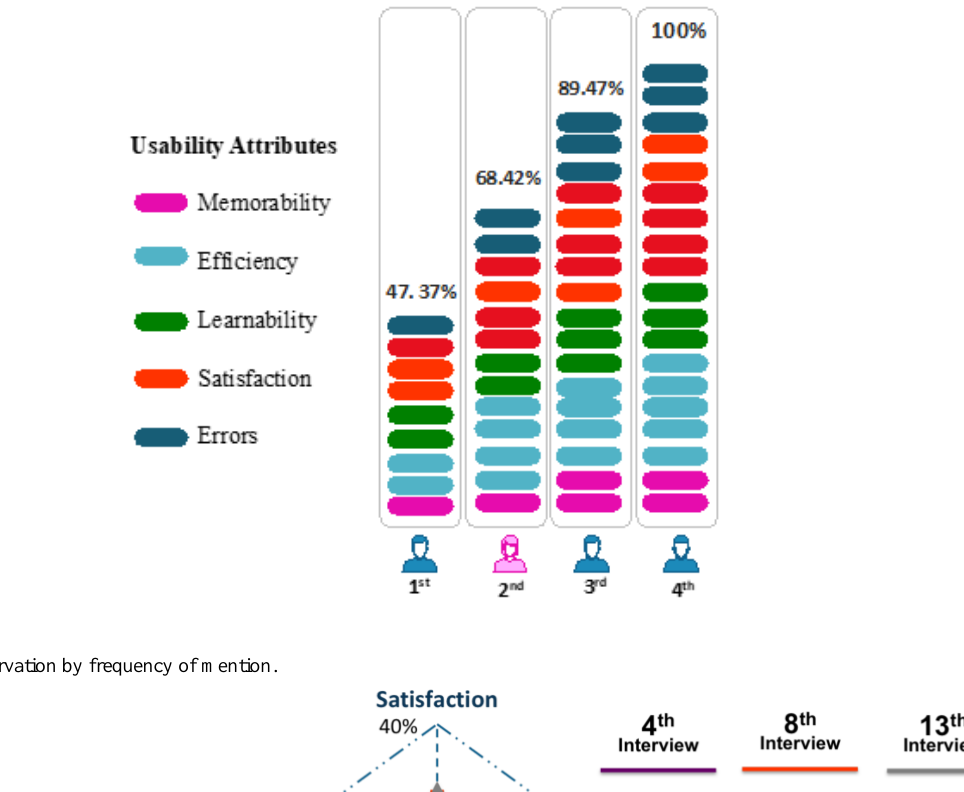
Figure 4. First observation to the 19 obtained usability themes.